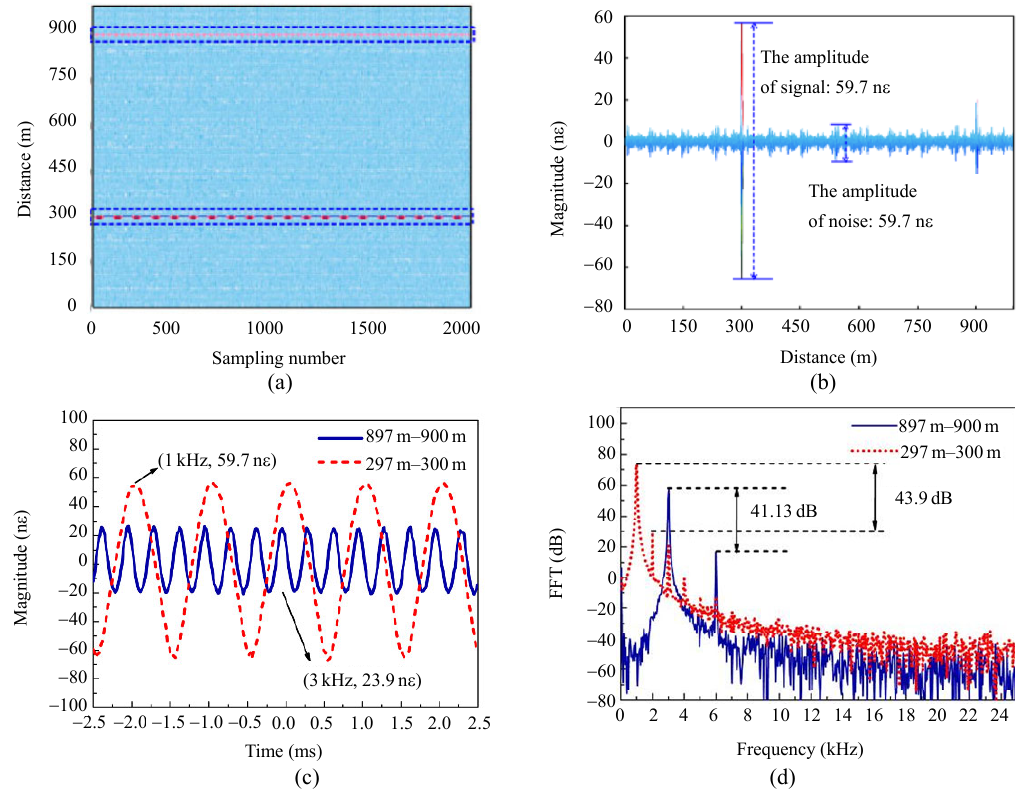
Fig. 11 Results of DVS experiment: (a) demodulated scalogram of the 12 V, 1 kHz, and 6 V, 3 kHz vibration signal at 300 m and 900 m, respectively, (b) demodulated phase changing diagram between 300 m and 900 m. It illustrates the amplitude of dynamic strain at different position, and (c) time responses of our system at 300 m and 900 m and (d) frequency responses of the demodulation results at 300 m, 900 m, and background.